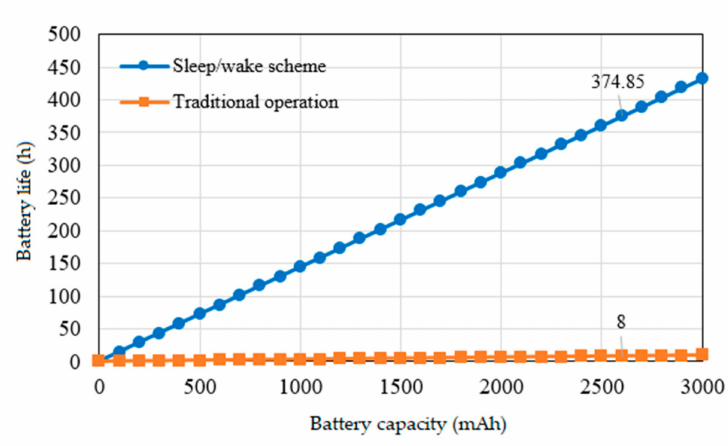
Figure 9. Estimated battery lifespan with respect to the battery capacity in the proposed monitoring